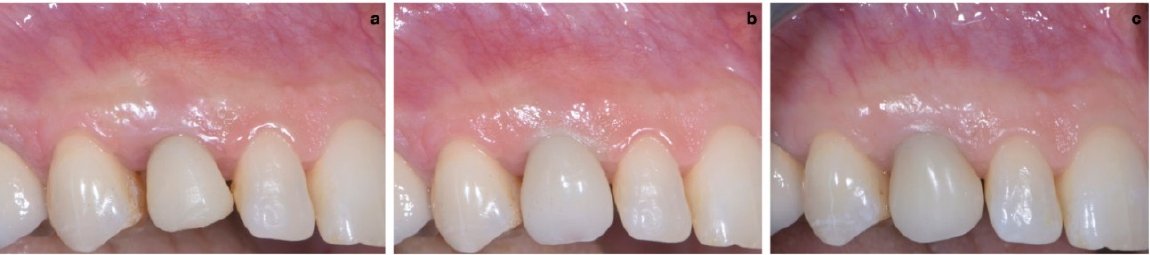
Figure 13. Maturation of soft tissue at 1 month ( a ), 3 months ( b ) and 6 months ( c ) after surgery.